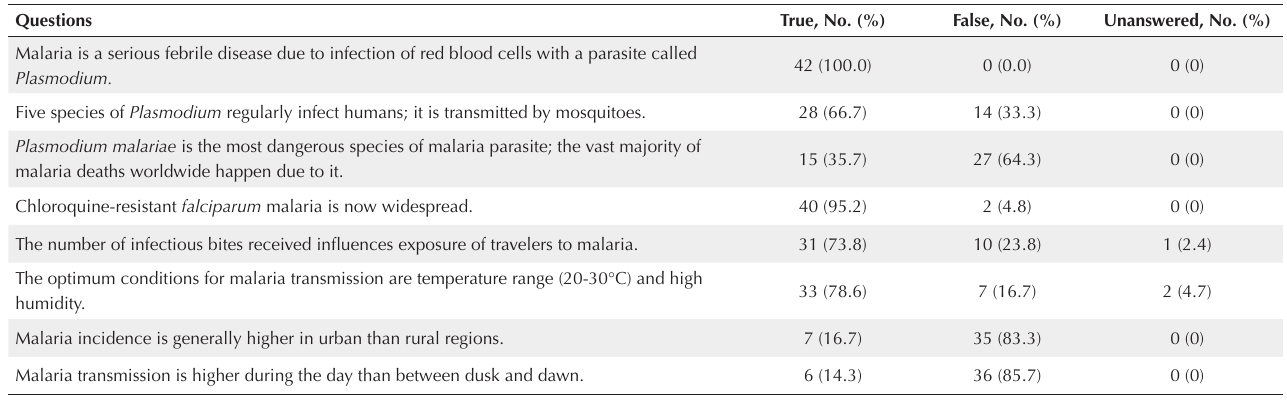
Table 2. Risk of Malaria Transmission During Travel Questions